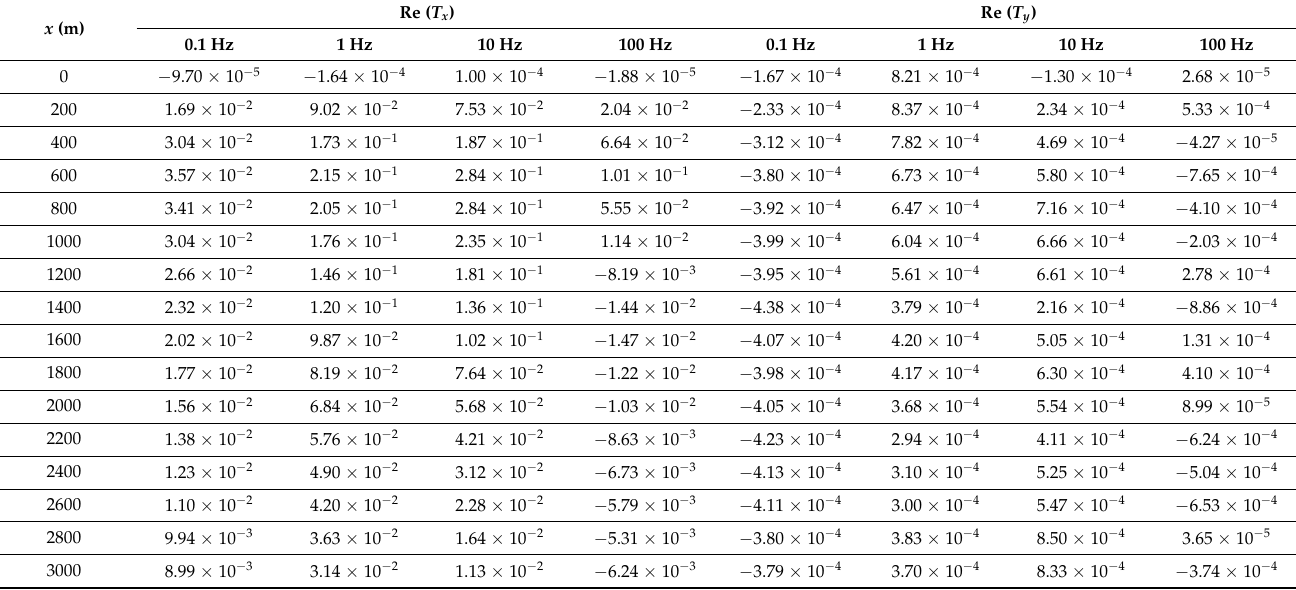
Table 2. The real parts of the tipper transfer function calculated by the FE method for the COMMEMI 3D-1A model. The y -coordinate is 0 m.